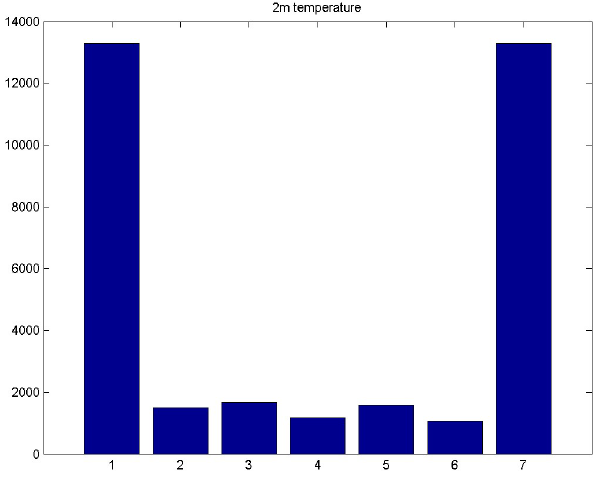
Figure 14: Rank histogram for all hourly near-surface temperature observations at 28 Climate Reference Network sites. 578